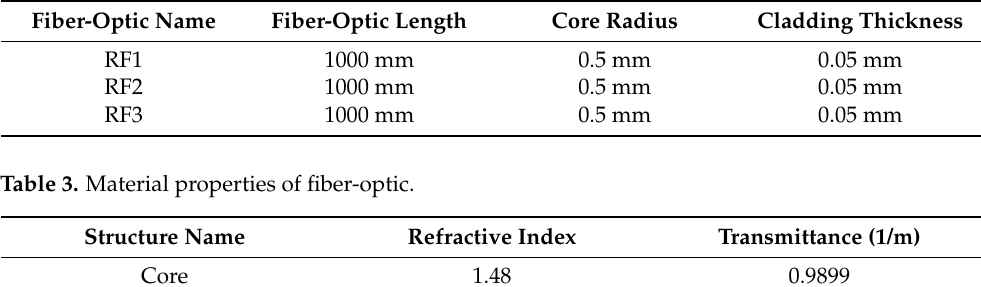
Table 2. Structural parameters of fiber-optic.